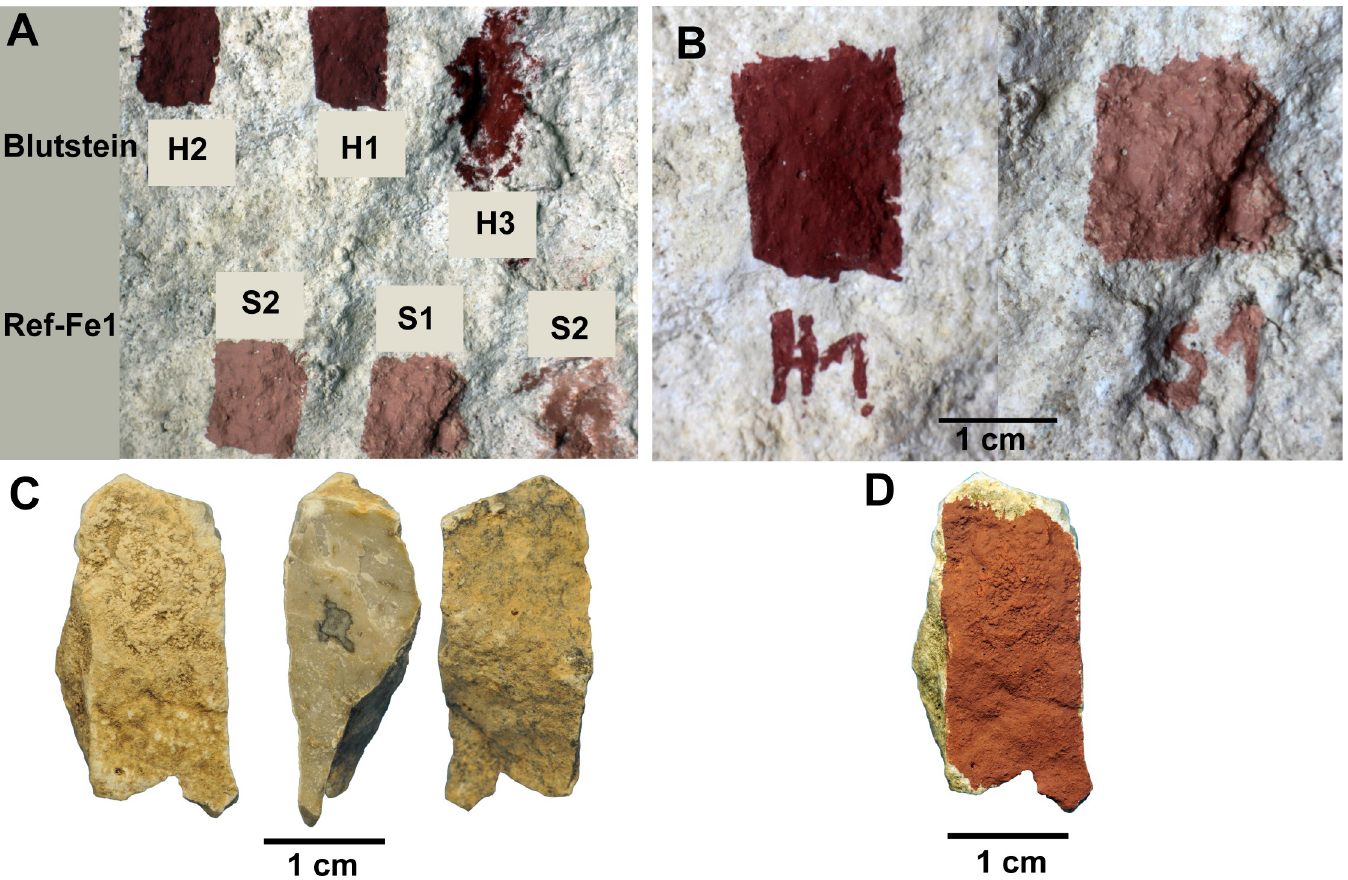
Fig 3. Pictures of the experimental paintings. A: paintings made on the Rupelian limestone (1: mixed with water, applied with a brush; 2: mixed with less water, applied with a brush; 3: powder directly applied with a finger). B: pictures of the selected experimental paintings H1 and S1 on the Rupelian limestone; C: fragment of El Castillo cave wall. D: same fragment with painting H1